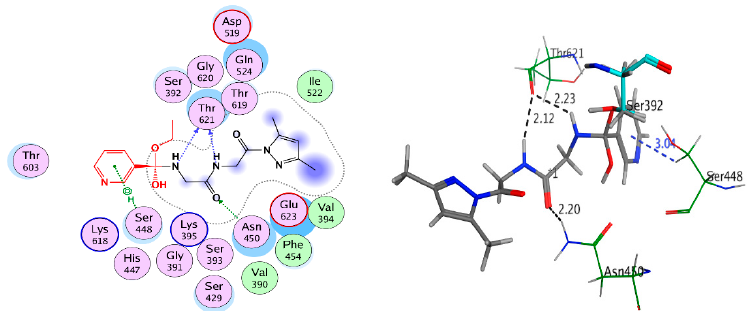
Figure 10. 2D and 3D covalent interaction of compound 8 with 3VSL.